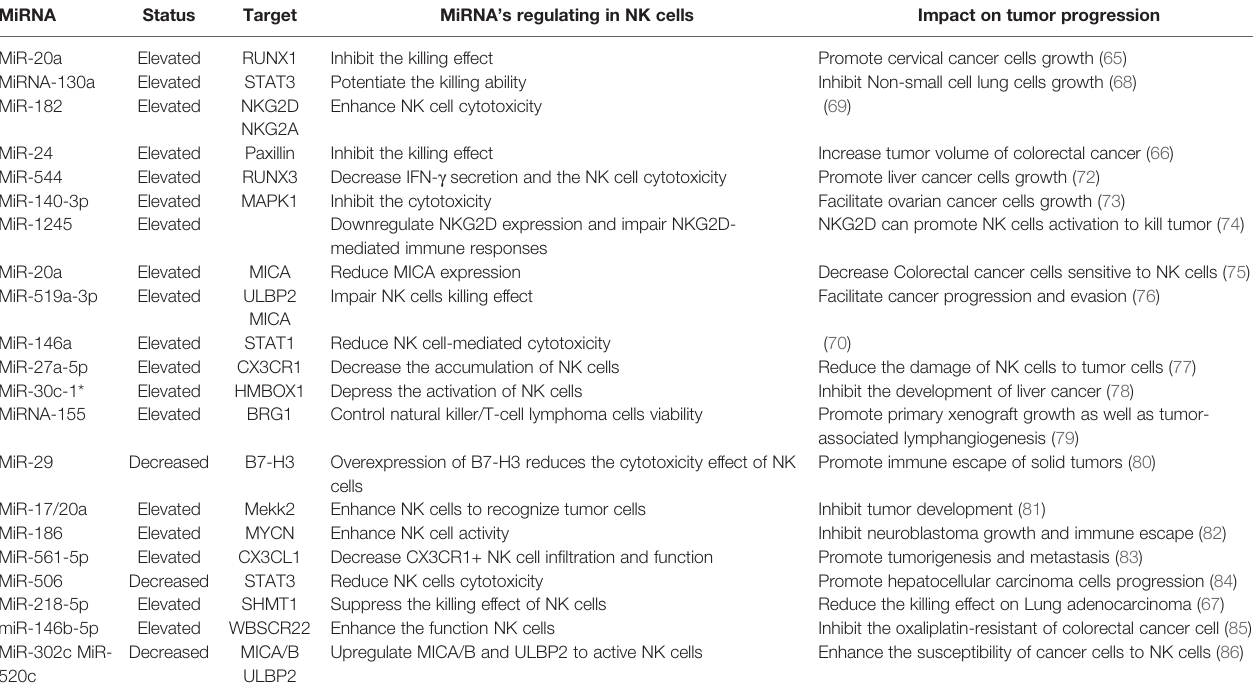
TABLE 2 | MiRNA related with NK cells in tumor progression.